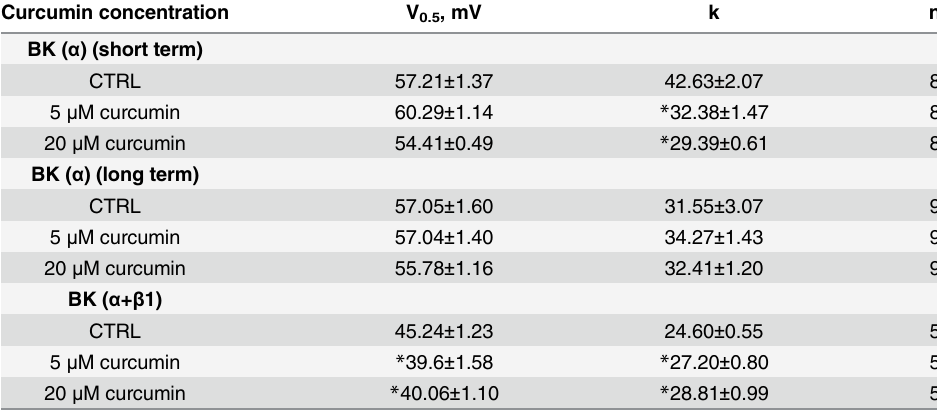
Table 1. The voltage dependent activation of BK channels in the absence and presence of curcumin. Significant difference between the groups of control and curcumin at the level of 0.05 was tested by one-way ANOVA. V 0.5 is the voltage for half-maximal activation, k is the voltage